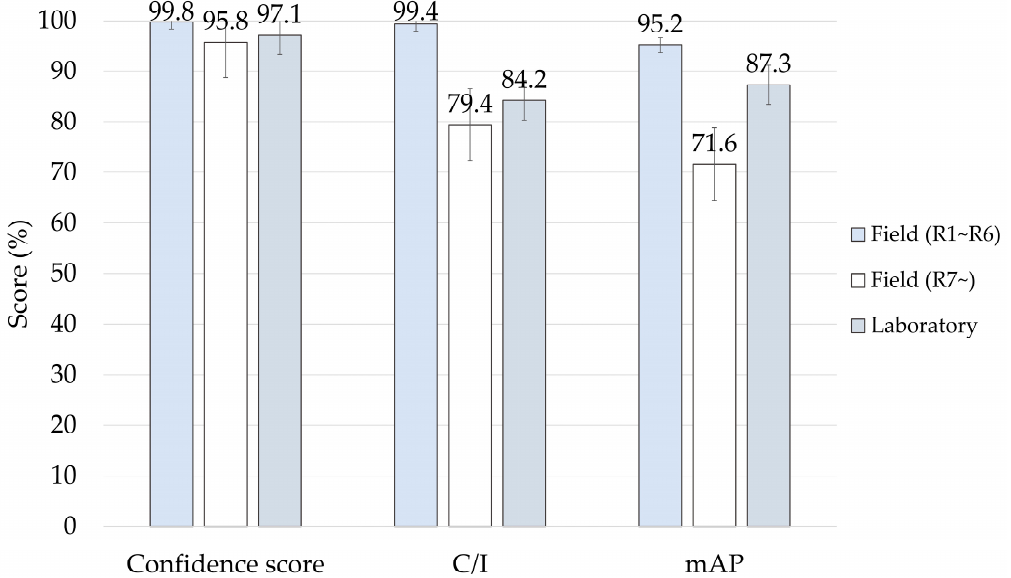
Figure 8. Confidence score and C/I, mAP index for each condition. The confidence score is an indicator of the accuracy and reliability of objects and classes detected by the deep learning model. C/I is an index indicating the ratio of objects detected by artificial intelligence to objects shown in the